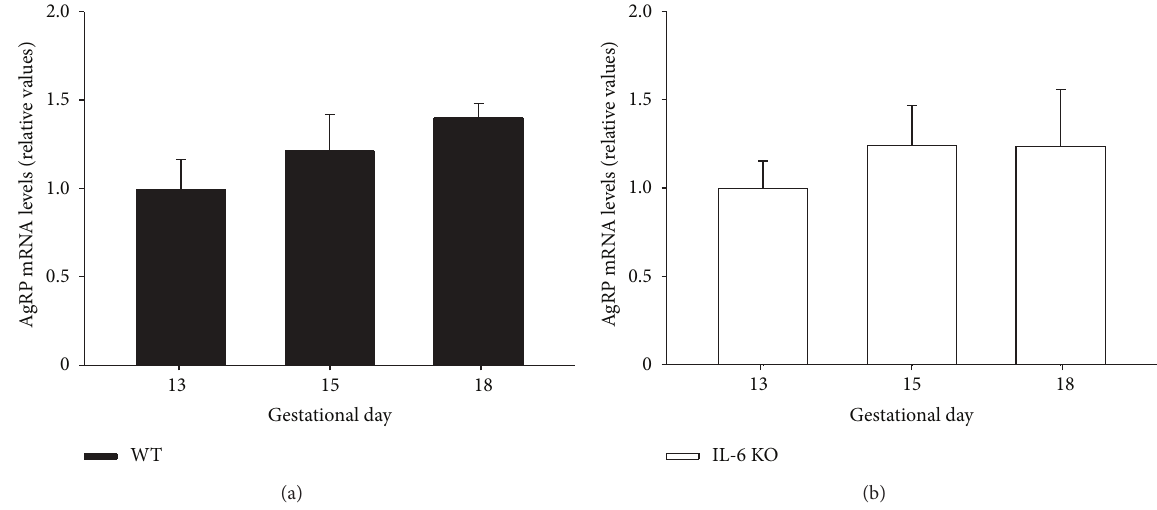
Figure 4: AgRP mRNA expression in placenta of WT and IL-6 KO mice. 12-week-old WT and IL-6 KO mice were time-pregnant and placental AgRP mRNA levels in (a) WT and (b) IL-6 KO mice at different pregnancy stages (13, 15, and 18 days) were assessed by real-time qPCR; 𝑛 = 5 - 6 . Within each genotype, relative mRNA levels were normalized to 13 days pregnant mice values as 1. Each value represents the mean ±